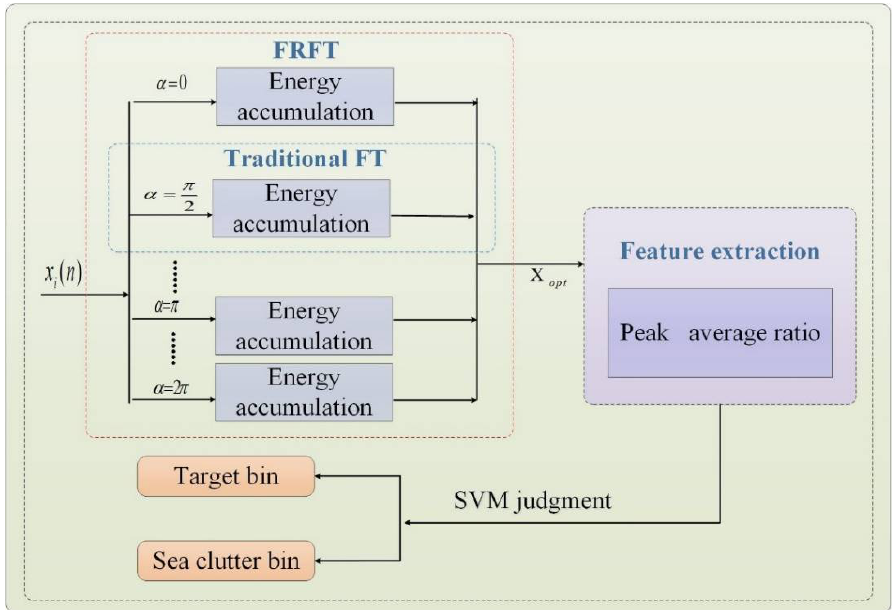
Figure 9. Flow chart of the proposed decision methods.